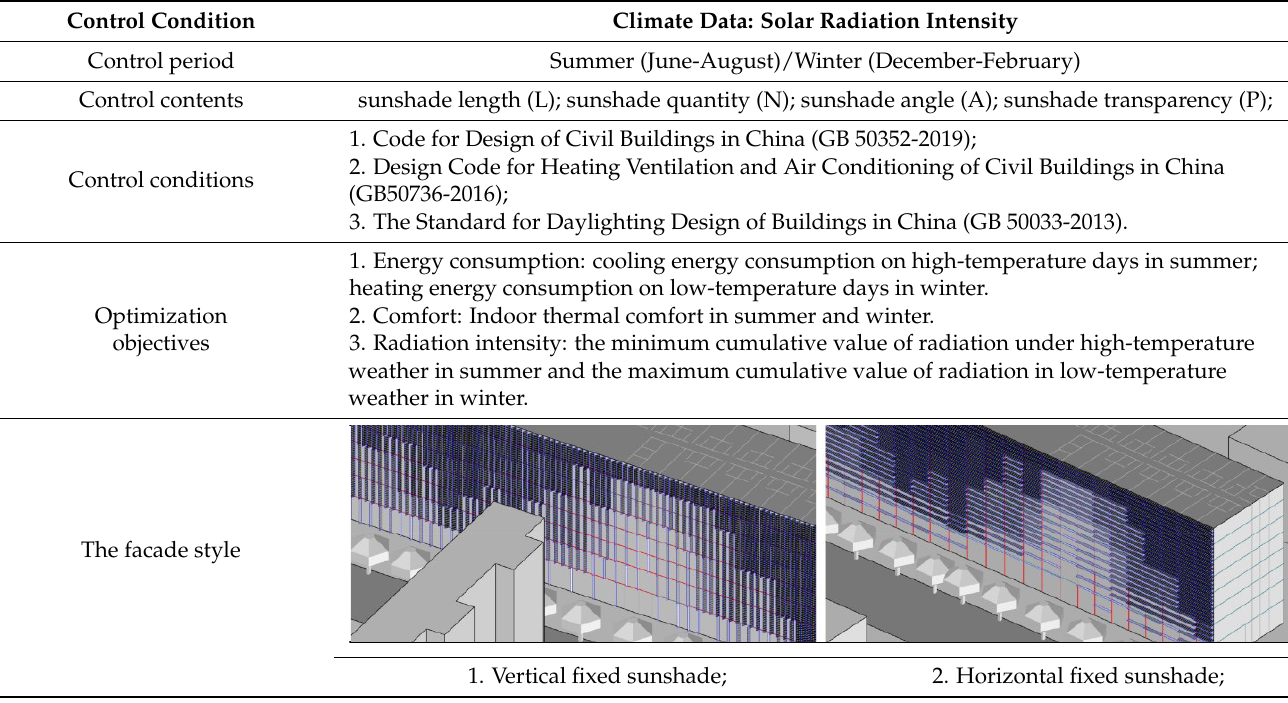
Figure 12. The relationship between meteorological data, shading form, and performance control. Table 3. The building facade shading form driven by building